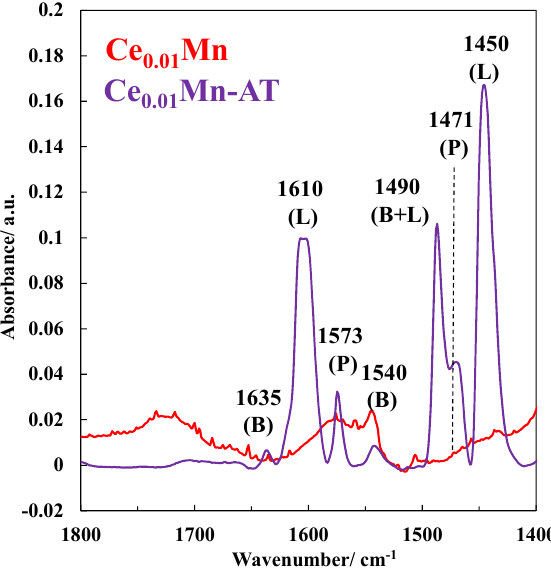
Figure 3. FTIR spectra of the Py region obtained after Py adsorption at 150 °C for the dried Ce 0.01 Mn and Ce 0.01 Mn-AT samples.